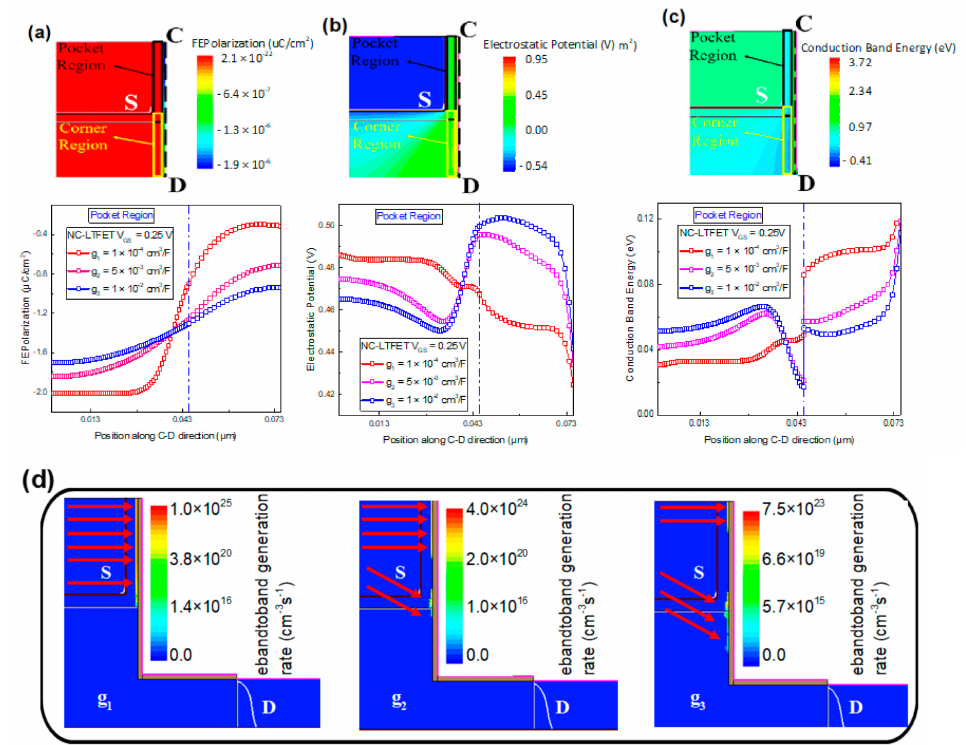
Figure 7. ( a ) Ferroelectric polarization of NC-LTFET along C-D direction at V GS = 0.25 V, ( b ) the electrostatic potential of NC-LTFET along C-D direction, ( c ) the conduction band energy of NC- LTFET along C-D direction and ( d ) the tunneling position of NC-LTFET with different g values at V GS = 0.25 V and V DS = 0.5